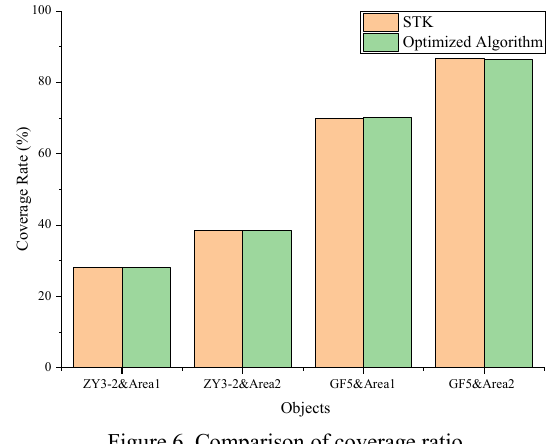
Figure 6. Comparison of coverage ratio